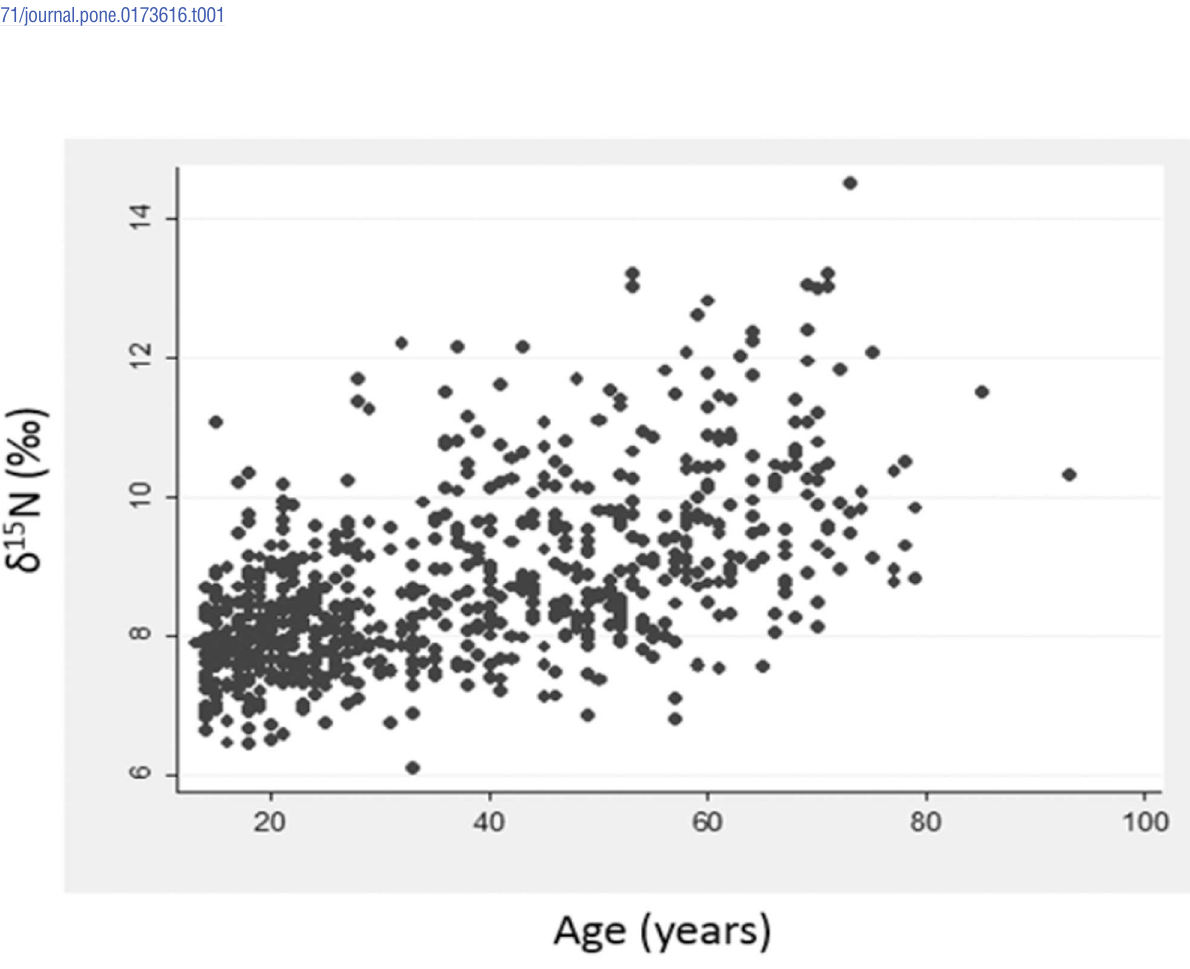
Fig 2. Plot of δ 15 N values in the study sample and association with age. (N = 733, P < 0.001,R 2 = 0.330). Higher δ 15 N values indicate increasedintake of ω 3 PUFAs.